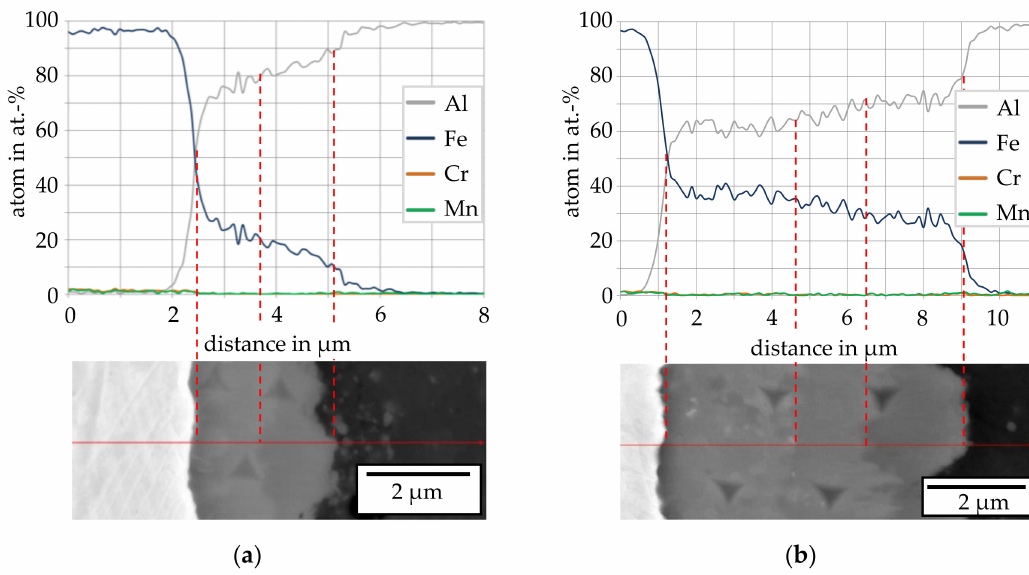
Figure 8. EDS and SEM analysis of the joining zone of a specimen for ( a ) 575 ◦ C, 120 s, 5890 N and ( b ) 590 ◦ C, 480 s, 5890